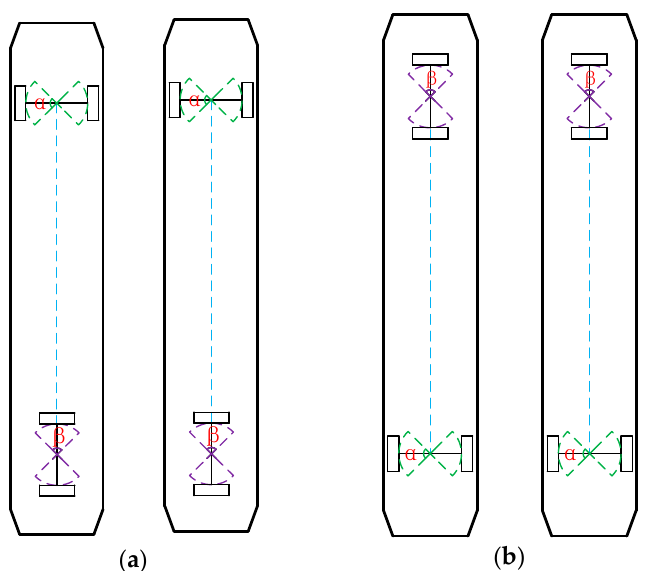
Figure 12. Dynamic adjustment strategy of master-slave robot during lifting and laying. ( a ) Angle adjustment areas; ( b ) Position adjustment areas.